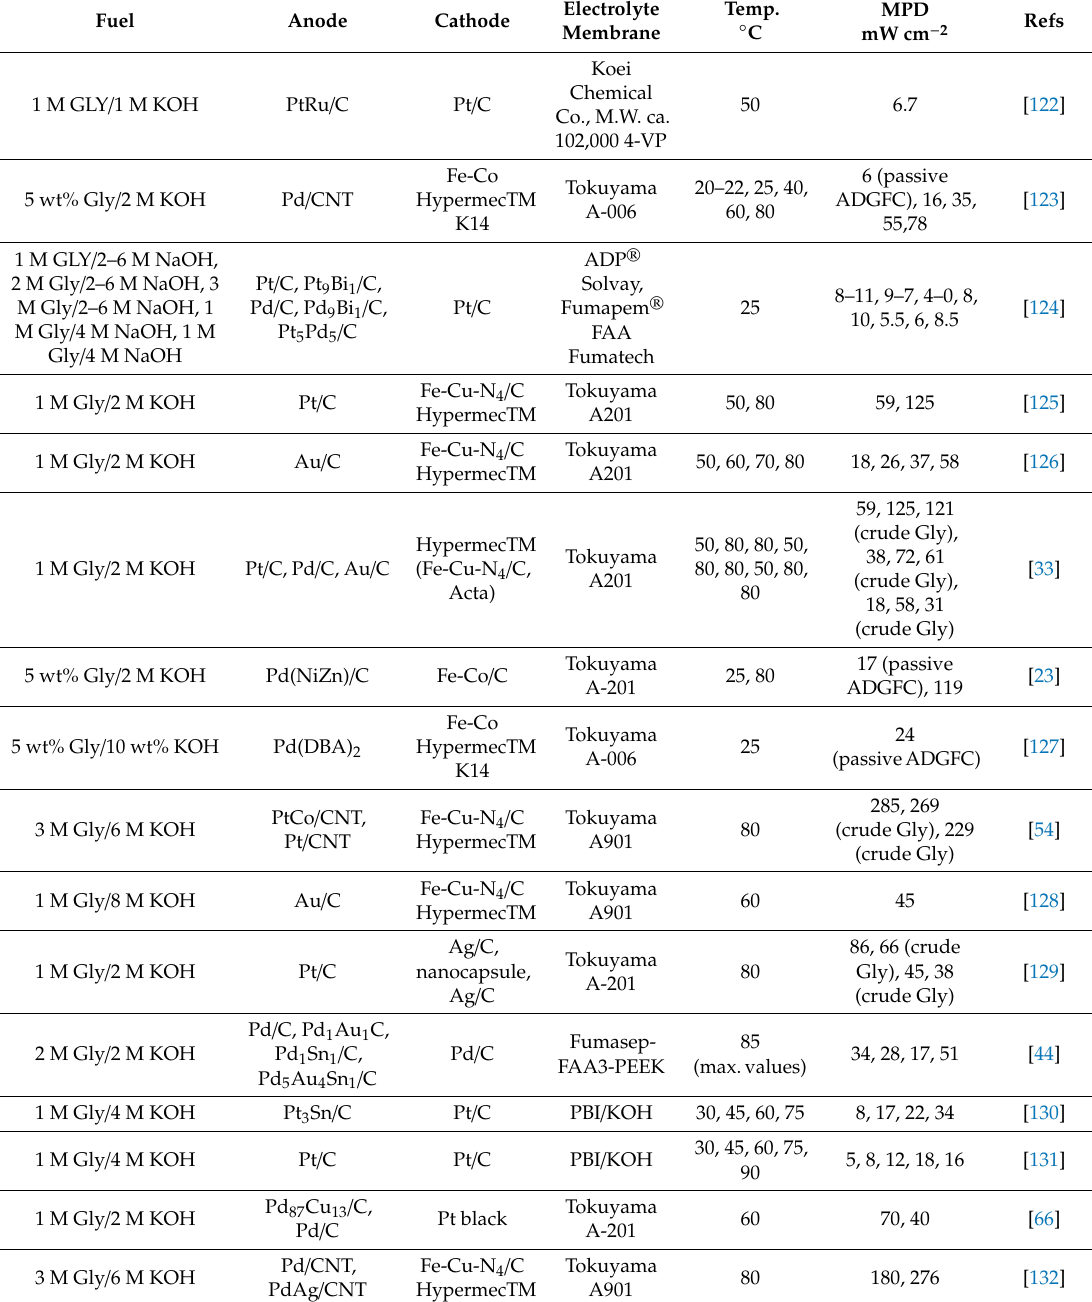
Table 4. Performance, in the term of maximum power density (MPD), of ADGFCs with di ff erent catalysts and alkaline anion-exchange membranes (AAEMs). Only temperature, GLY and MOH (M = K, Na) concentration are reported in operating conditions, but it has to be remarked that MPD depends also on other parameters such as catalyst loading, gas flow and pressure. * Membraneless fuel cell; ** photochemical fuel